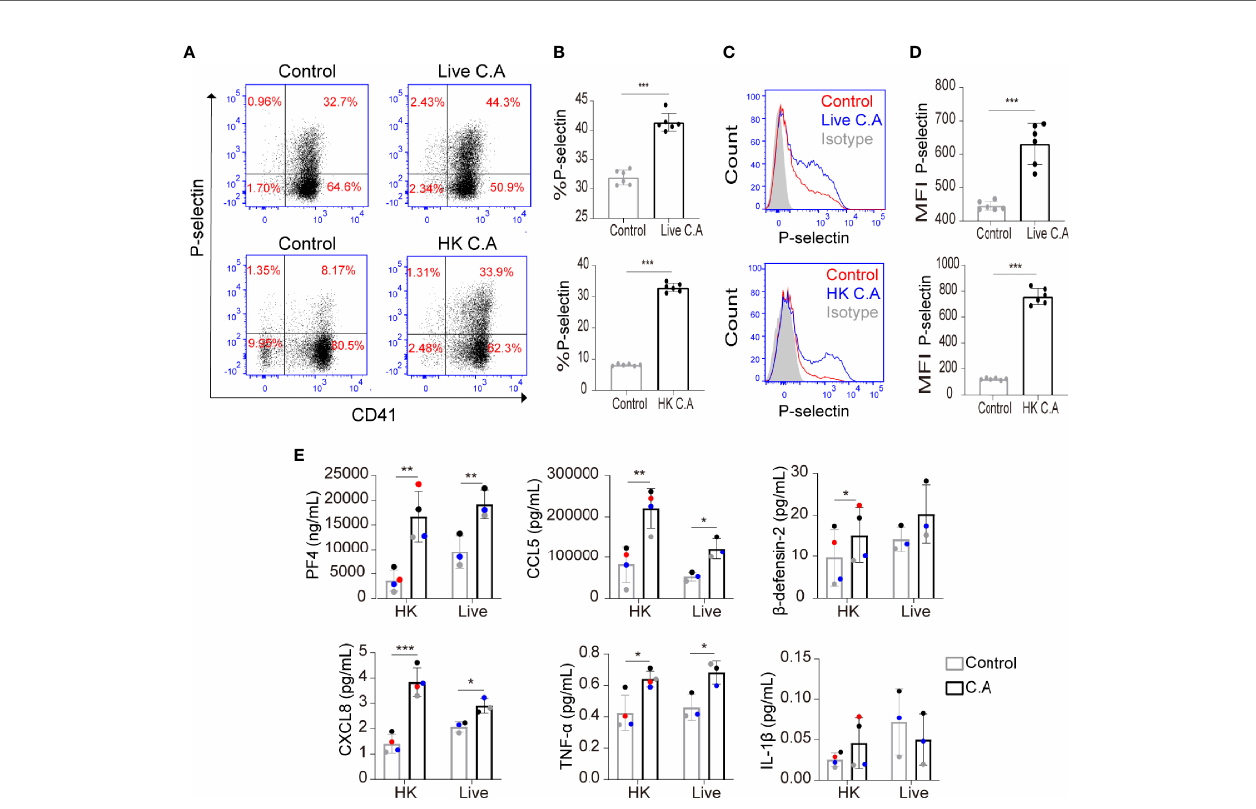
FIGURE 1 | C. albicans induces platelet activation. (A – E) Platelet-rich plasma (PRP) was incubated with live C. albicans ( A – D , top column) for 2 h or heat-killed (HK) C. albicans ( A – D , bottom column) for 6 h at a multiplicity of infection (MOI) of 0.01. PRP incubated with equal volume of PBS was used as control. Cells were fi xed, stained for the general platelet marker CD41 and the activation marker P-selectin and analyzed using fl ow cytometry. Representative dot plots (A) and fl ow cytometry histograms (C) are shown. The percentages (B) and mean fl uorescence intensity (MFI) (D) of P-selectin-positive cells were calculated. (E) PRP from a single donor was paired to be treated with either C. albicans or PBS. Levels of PF4, CCL5, b -defensin-2, CXCL8, TNF- a and IL-1 b in coculture suspension were determined by enzyme-linked immunosorbent assay (ELISA). The two data points from a single donor were presented with the same color. Data represent two or more independent experiments. Data are expressed as the mean ± SD determined by unpaired (B, D) or paired (E) Student ’ s t test; * P < 0.05, ** P < 0.01, *** P < 0.001. C.A, C. albicans ; HK,